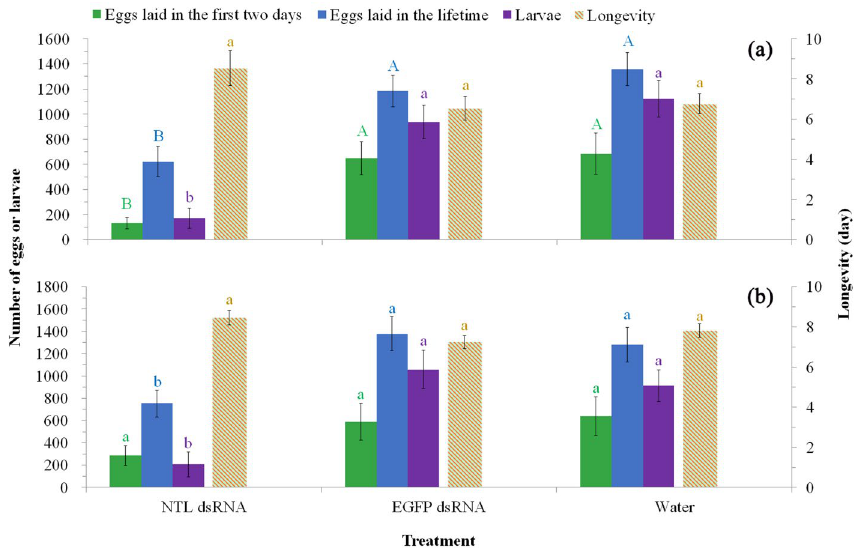
Figure 6. Effects of NTL RNAi on female ( a ) and male ( b ) reproductive output and longevity (mean number of days the adults live, i.e., the duration from moth eclosion to death). For each parameter (Eggs laid in the first two days, Eggs laid in the lifetime, Larvae or Longevity) of RNAi on female ( a ) or RNAi on male ( b ), bars with different letters are significantly different (different uppercase letters indicate P < 0.01 and different lowercase letters indicate P < 0.05); i.e., letters with the same color can be compared to derive the significance of difference between treatments in the same subgraph, ( a ) or ( b